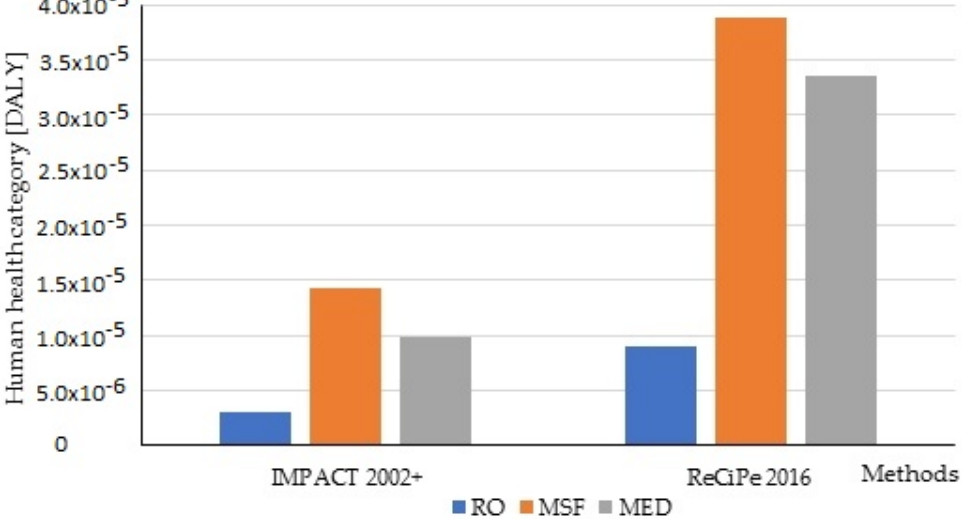
Figure 12. Human health damage of desalination technologies. Table 7. Results for the human health category for the three technologies based on the ReCiPe 2016 and IMPACT 2002+ methods.